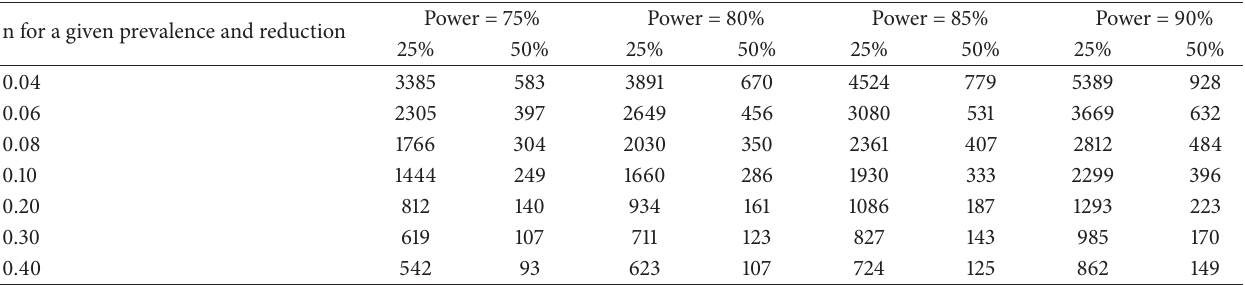
Table 1: Sample size calculations table according to different treatment